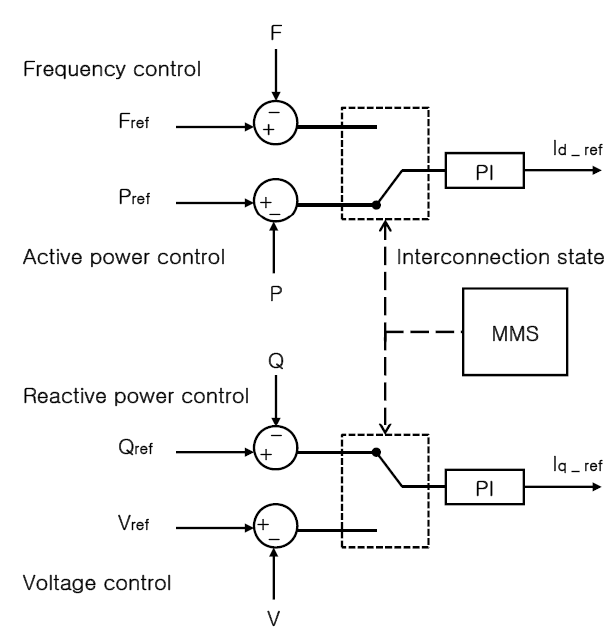
Figure 5. Current control scheme of